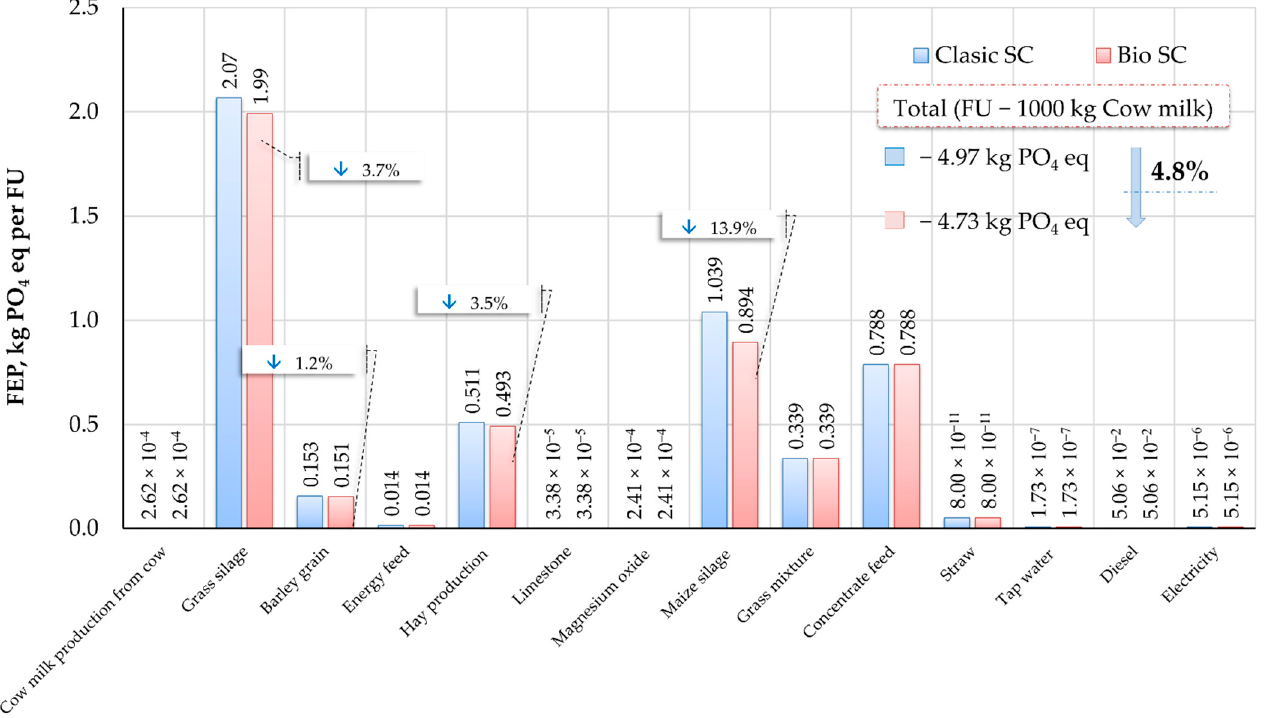
Table 4. Environmental impact of other Bio SC impact categories (for FU = 1000 kg of milk).